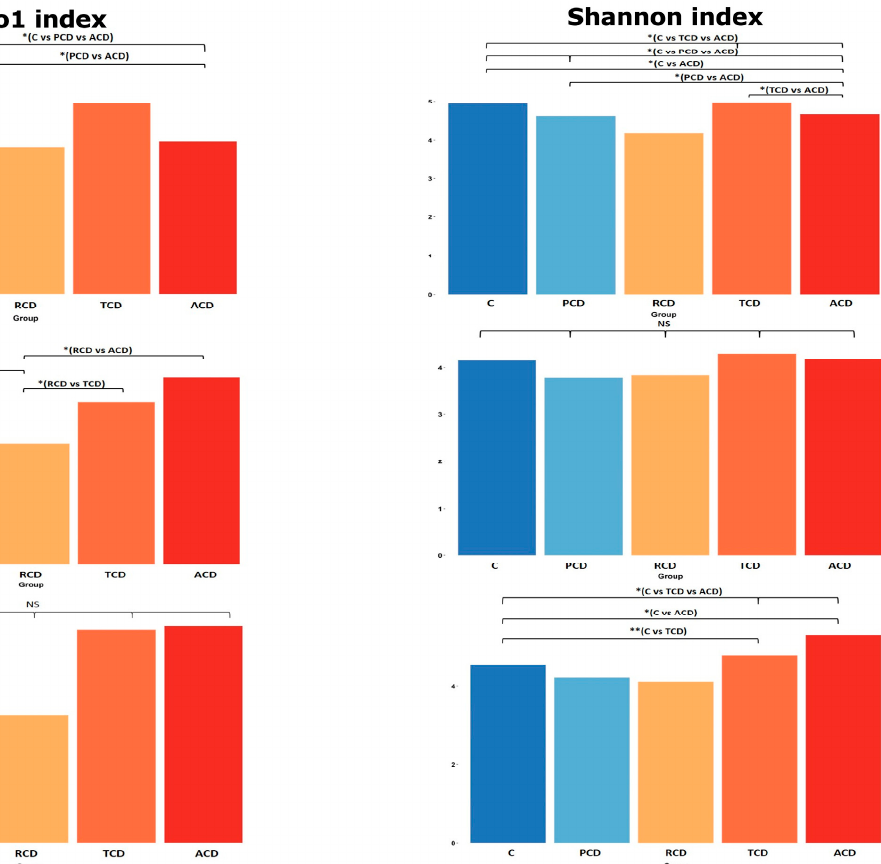
Figure 4. Beta-diversity comparison for the mucosal microbiota: Multidimensional Scaling (MDS) plots of mucosal samples for which the Permutational Multivariate Analysis of Variance test detected a significant separation of study groups in terms of bacterial community composition. The microbiota phylogenetic distances were evaluated through the generalized UniFrac distance. Each point represents the microbiota composition of one sample. Panel ( A ): all patient groups were compared. Panel ( B ): TCD versus ACD comparison. Panel ( C ): ACD versus C comparison. Each point represents the microbiota composition of one sample. 3.2. Taxonomy-Based Analyses of Mucosal Community As shown in Table 3, the phylum distribution is indicative of a decrease in Actinobacteria and an increase in Proteobacteria in all celiac groups, with ACD being that with the greatest deviation with respect to C. A different pattern is observed for Bacteroidetes that are decreased in ACD and increased in the other CD groups in comparison to C. Although Firmicutes are the most abundant phylum, accounting for a portion of bacterial diversity ranging from a maximum of 43.6% in C to a minimum of 34.8% in ACD, with the other CD groups displaying intermediate values (39.5% in PCD, 37.5% in TCD, and 40.16% in RCD), no significant differences are seen. Moving on to bacterial families within the Veillonellaceae are the lowest in ACD, and the Lachnospiraceace are the lowest in both ACD and RCD,